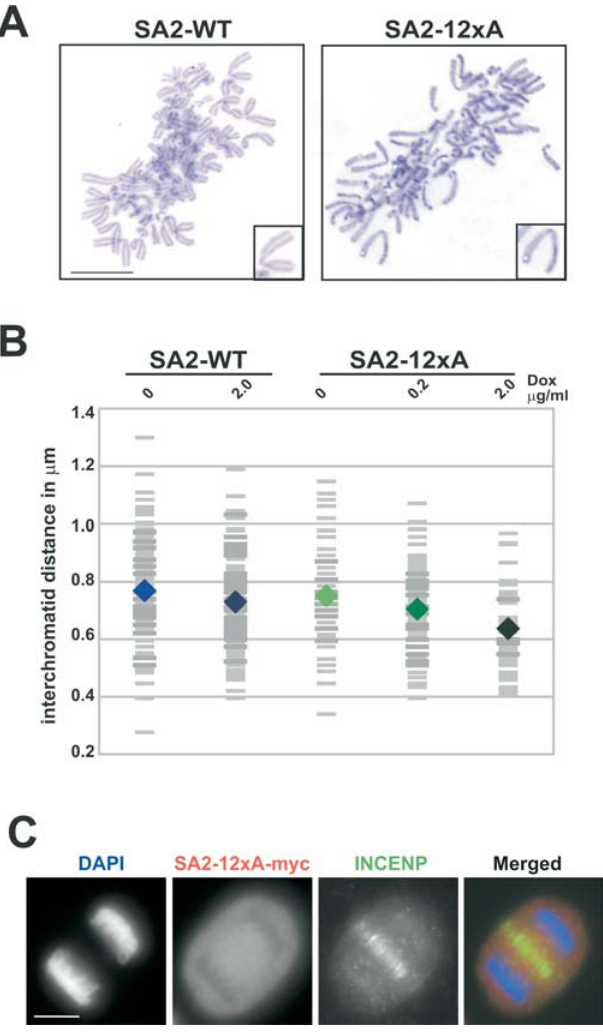
Figure 7. Phosphorylation of SA2 Is Required for Efficient Resolution of Sister Chromatid Arms during Prometaphase and Metaphase (A) HeLa cells expressing SA2-WT-myc or SA2–12xA-myc were spread on glass slides and chromosomes were stained with Giemsa. Representative cells from SA2 WT-myc or SA2–12xA-myc cell lines after induction with 2 l g/ml doxycycline are shown. Scale bar 10 l m. (B) HeLa cells were induced to express SA2-WT-myc or SA2–12xA- myc by different amounts of doxycycline as indicated, and processed as in (A). More than 50 cells in prometaphase or metaphase were selected randomly from each sample. The distance between sister chromatids was determined for five chromosomes in each cell and averaged. Light gray bars indicate average values that have been measured in one or two cells, and darker gray bars indicate average values that have been measured in three or more cells. Diamonds indicate the average distance for all cells in a given sample. (C)Representativeimmunofluorescenceimageofnormalanaphaseina cell expressing SA2–12xA-myc. The cell was not extracted prior to fix- ation,sothesolublepoolofSA2–12xA-mycisrevealedbymyc-staining. DOI: